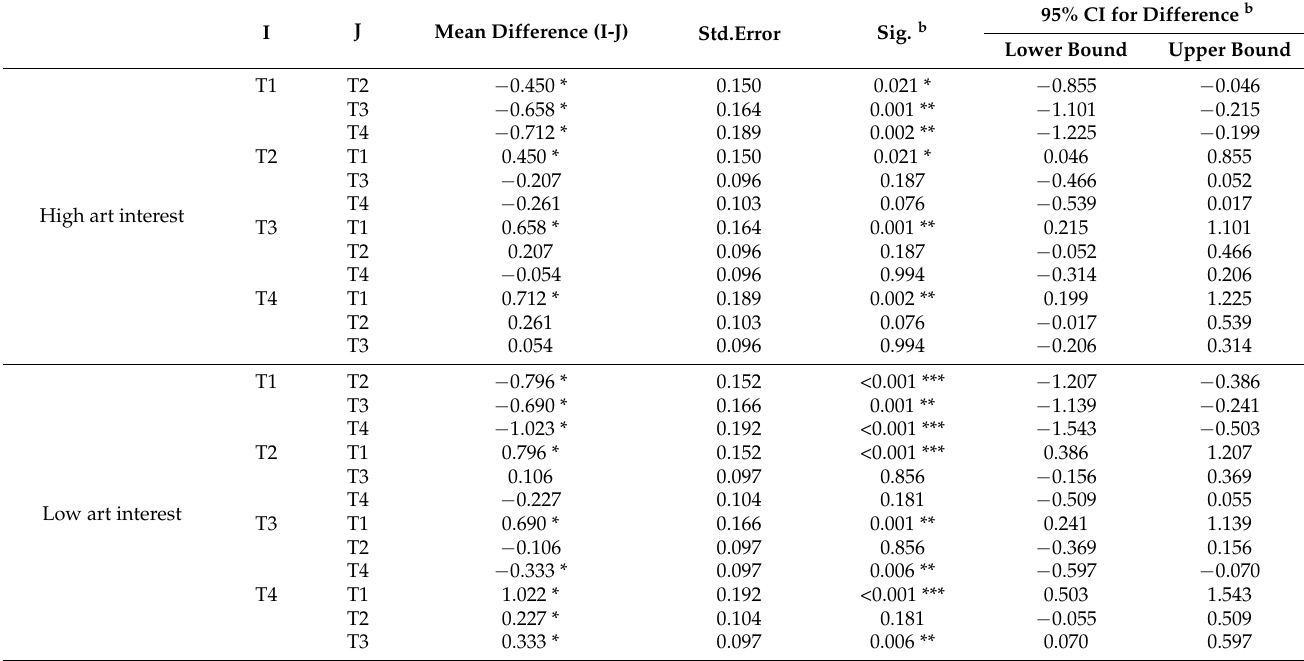
Table 8. Pairwise comparisons.